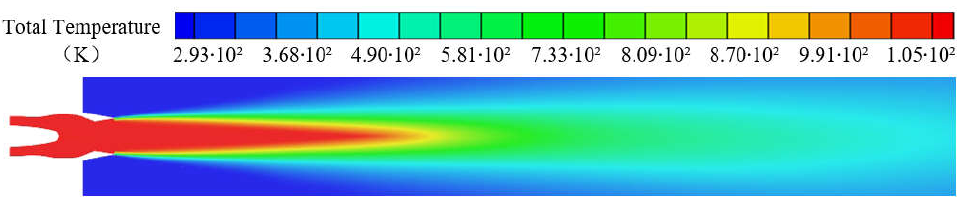
Figure 4. Cloud chart of total temperature.